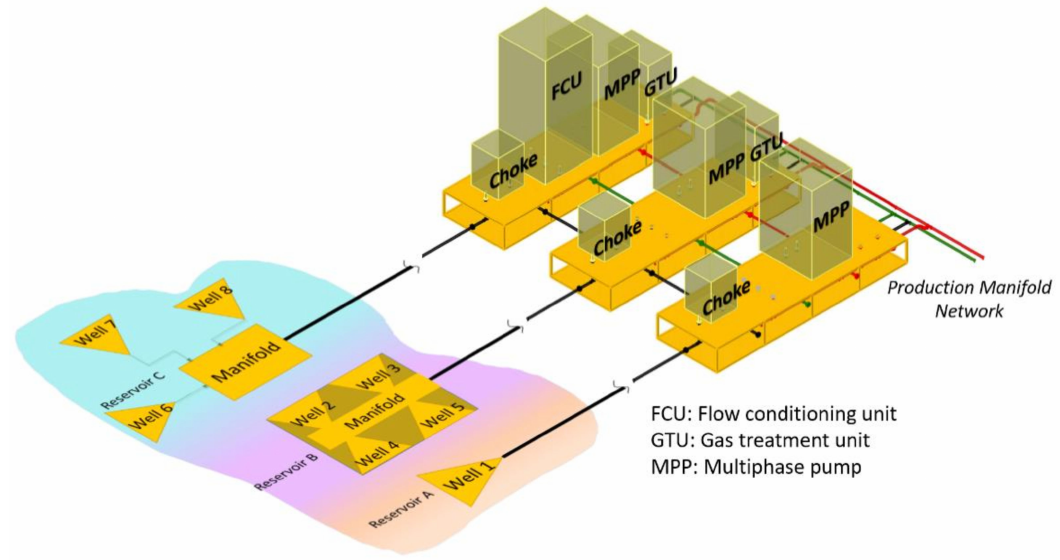
Figure 1. Subsea gate box concept [3].